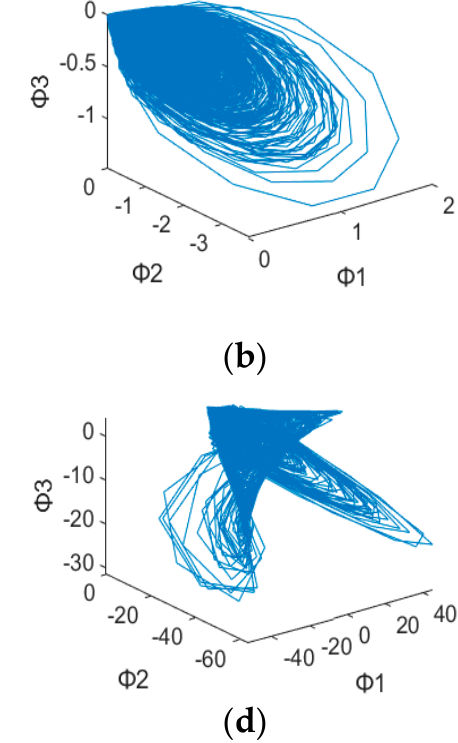
Figure 5. 3D dynamic error phase diagram of ball bearing under testing, with α = 0.6, HP = 0, and SPOF diameter = 0.007 in. ( a ) Normal state. ( b ) Ball fault. ( c ) Inner race fault. ( d ) Outer race fault.